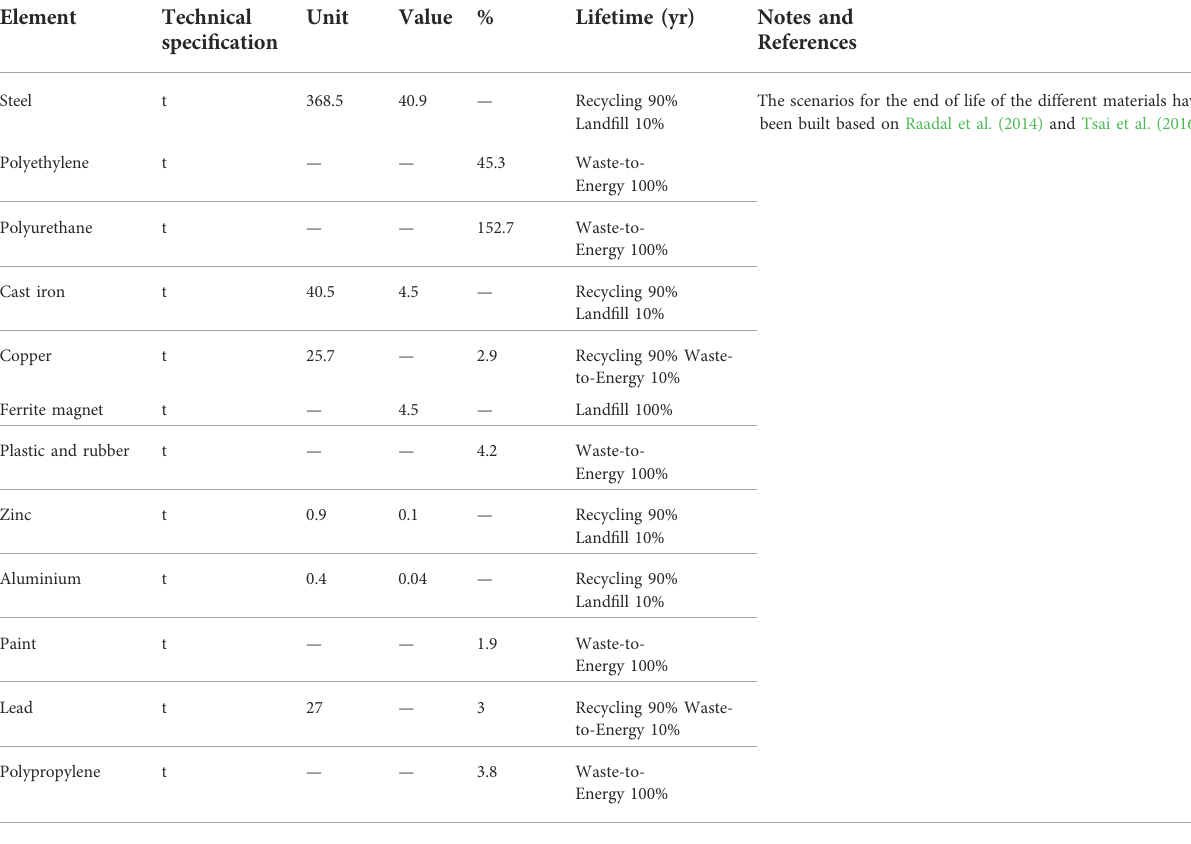
TABLE 4 ( Continued ) Life Cycle Inventory data for a wave park hosting 25 generic seabed-based buoys. Values in bold represent totals and subtotals.